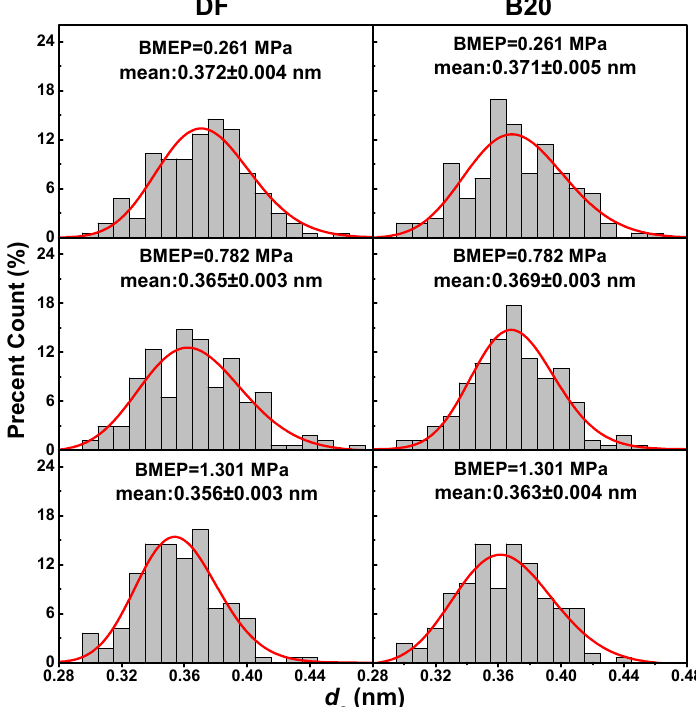
Figure 6. Histograms of separation distance (d s ) data for both DF and B20 soot in the applied test modes.